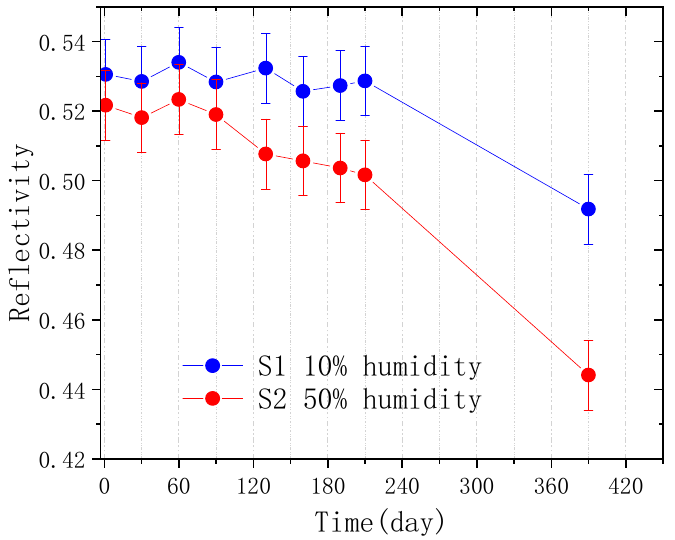
Figure 2. The changes in the 1st order peak reflectance in the two Pd/B 4 C multilayers with storage time.